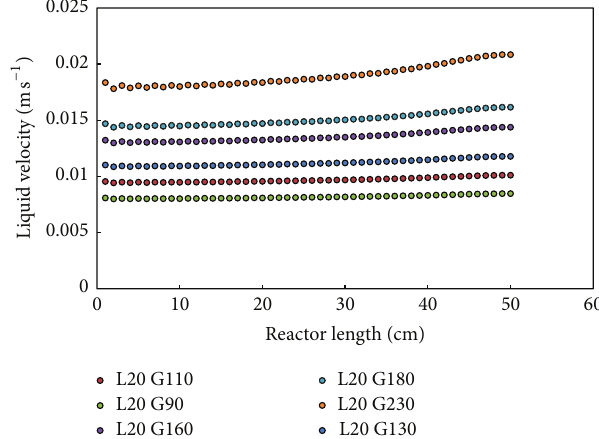
Figure 9: Calculated liquid velocity profiles along the reactor for a liquid flow rate of 20 mLmin −1 and various gas flow rates.